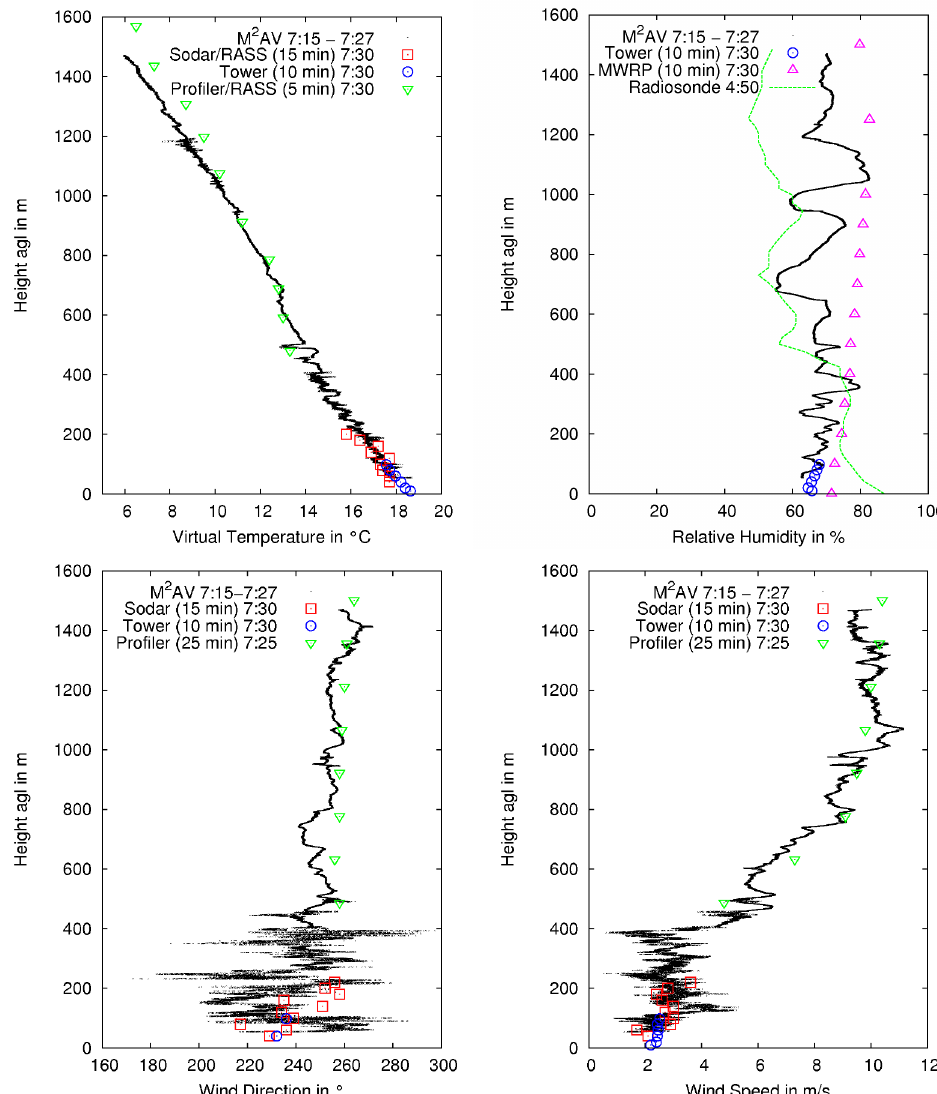
Fig. 8. Vertical profiles measured by wind profiler/RASS, sodar/RASS, tower, MWRP, radiosonde ascent and M 2 AV. These data were collected during the descent of the morning flight of the UAV on 21 July 2009 near MOL-RAO. Besides for the M 2 AV, the times indicated in the captions mark the end of the averaging interval.